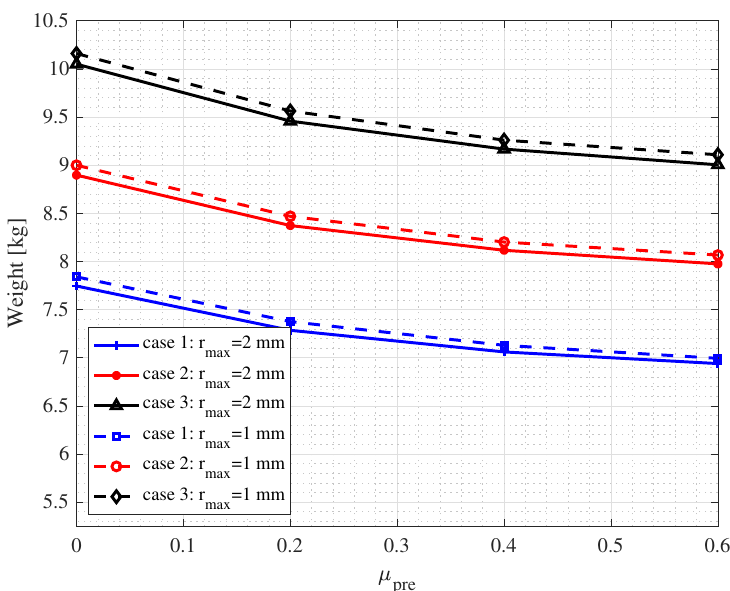
Figure 6. Calibration of packing densities for preparing numerical samples: since the initial heights for the three experiments were controlled, see Figure 3b, to calibrate the densities, the total weights of sands are calibrated by controlling the friction parameter µ pre .